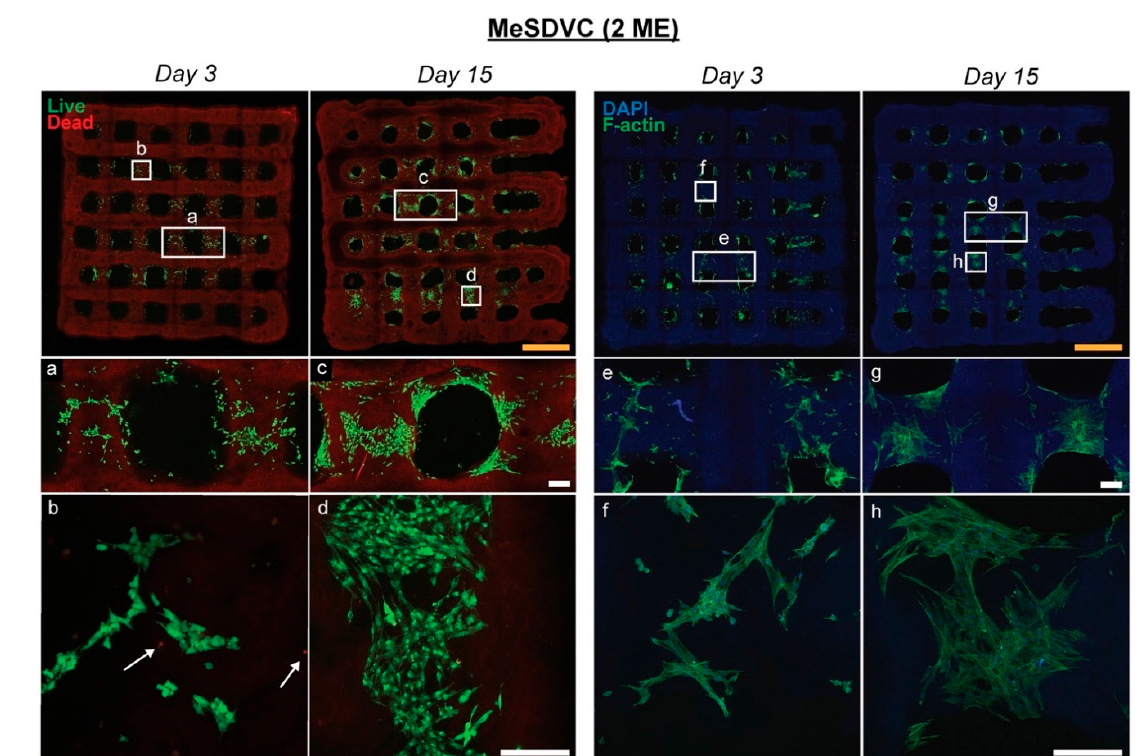
Figure 7. The printed 2 ME MA MeSDVC hydrogels supported rat bone marrow-derived mesenchymal stem cell (rBMSC) viability and adhesion over 15 days. The 2 ME MA MeSDVC was printed into four-layer grids, crosslinked with UV light, and rBMSCs were seeded onto the scaffolds for 15 days (n = 3). Live/dead staining (left) and F-actin/DAPI staining (right) were performed after 3 and 15 days of culture to assess viability and adhesion. The printed struts were visible from autofluorescence in the dead and DAPI channel (top row). At both time points, rBMSCs exhibited high viability and limited cell death (dead cells indicated by white arrows in insets b and d). From the F-actin and DAPI staining, after 3 days, cells were distributed loosely around the struts in comparison to after 15 days, where cells were tightly adhered around the printed strut and had increased spreading. Yellow scale bars: 2 mm. White scale bars: 200 µm.